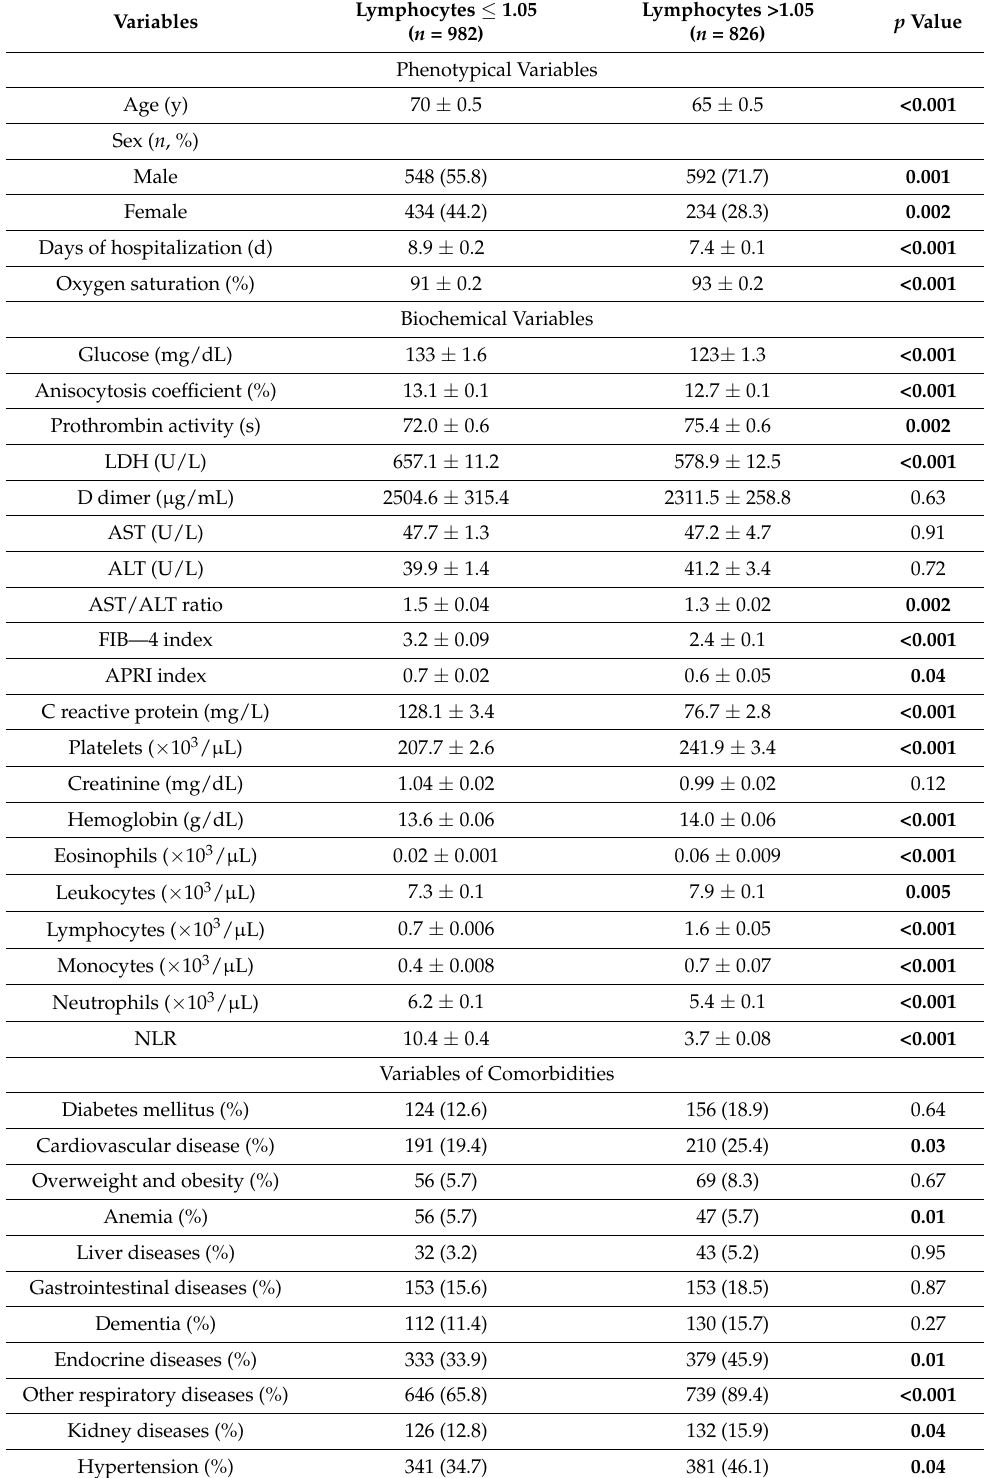
Table 2. Comparison of clinical and phenotypical variables of COVID-19 infected patients according to lymphocytes